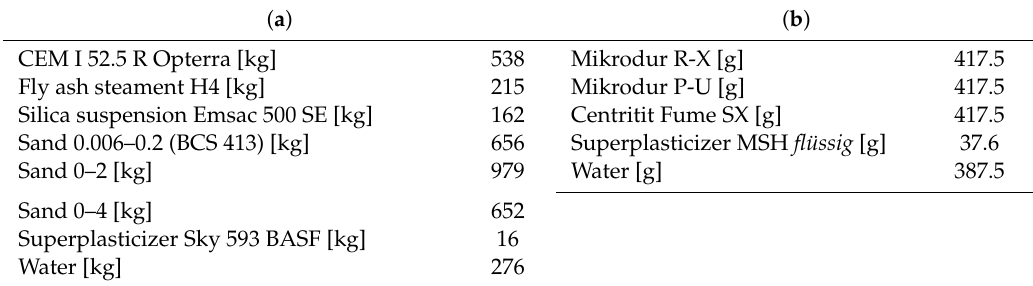
Table 2. Composition of: ( a ) 1 m 3 fine-grained concrete and ( b ) 1 litre mineral